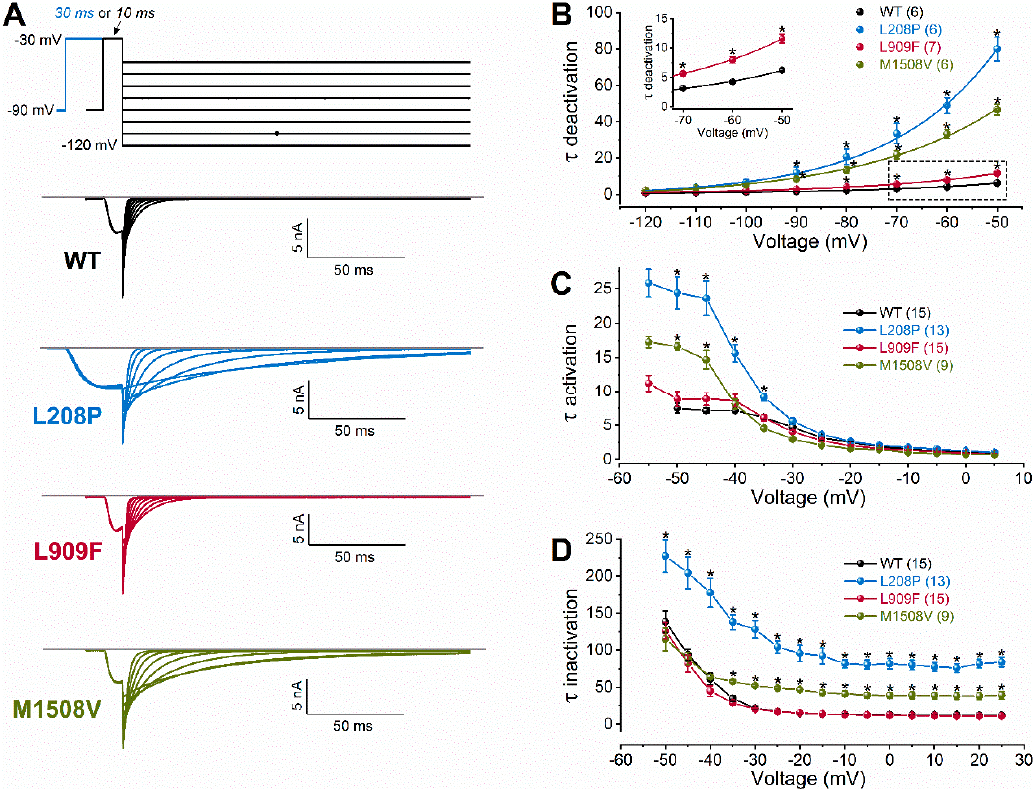
Figure 2. Voltage dependence of wild-type (WT) and mutant Ca v 3.1 current kinetics. ( A ), Representative tail currents, elicited by 10- or 30-ms conditioning test pulses to − 30 mV. Deactivation was recorded during subsequent repolarizations to test potentials from − 120 to +50 mV, in 10-mV increments. For clarity, only current traces elicited by test potentials from − 120 to − 50 mV are shown (top: voltage protocol). Horizontal grey lines indicate zero-current levels. ( B ), Mean time constants of deactivation, resulting from fitting the deactivating current traces with a single-exponential function (Equation (2)). Inset shows boxed τ deactivation values on an expanded scale. ( C ), Mean time constants of activation, obtained from fitting the inward current component underlying activation. ( D ), Mean time constants of inactivation, obtained from fitting the inactivating phase of the current. Data are mean ± SEM; the number of experiments is shown in parentheses; The p values of ‘Ca v 3.1 variant ∗ voltage’ interaction associated with the time constants of activation, inactivation, or deactivation kinetics were < 0.0001. Asterisks indicate statistically significant differences compared to WT ( p < 0.05 in two-way ANOVA followed by Dunnett’s post hoc test); see also Table